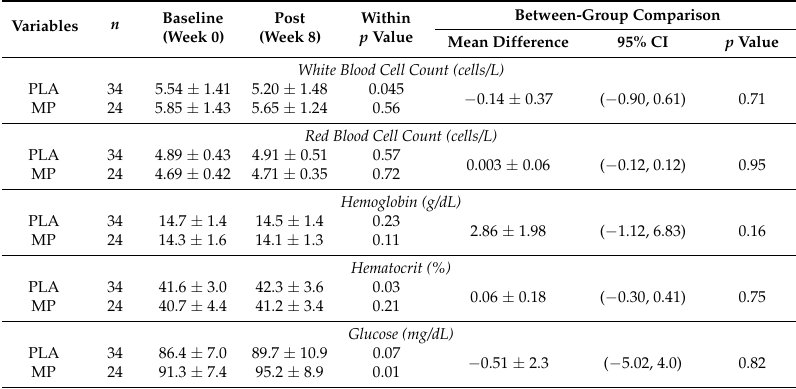
Table 5. Serum and Whole Blood Clinical Markers of